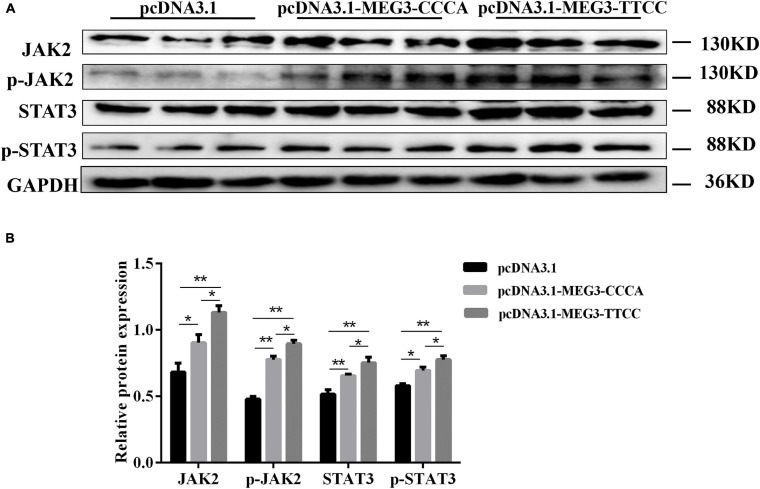
Overexpression of MEG3 haplotypes inactivated JAK2/STAT3 signaling pathway in SCs. (A) SCs lysates were immunoblotted with anti-JAK2, p-JAK2, STAT3, and p-STAT3 antibodies in pcDNA 3.1(+), pcDNA3.1-MEG3-CCCA, or pcDNA3.1-MEG3-TTCC groups. (B) Relative Protein expressions level of JAK2, p-JAK2, STAT3, and p-STAT3. The significance test: *P < 0.05, **P < 0.01.